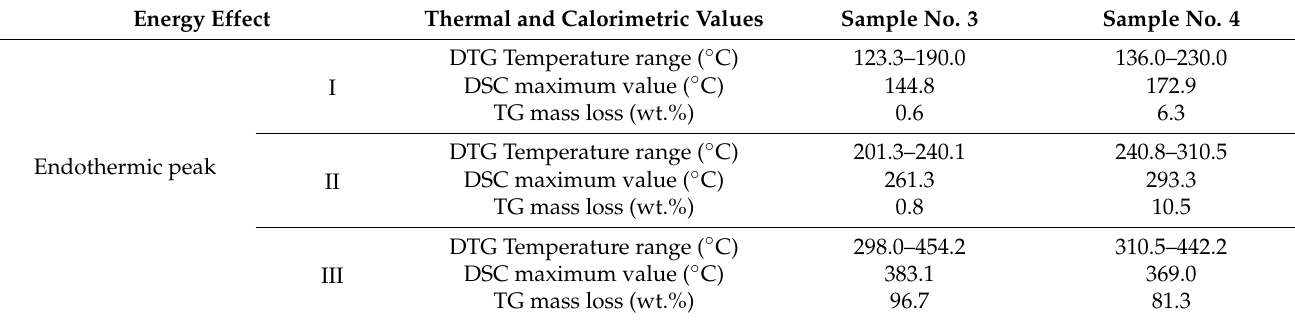
Figure 6. The TG/DTG–DSC curves for Eu:2,6-DClB/PMMA. Table 3. TG/DTG–DSC data for samples No. 3 and